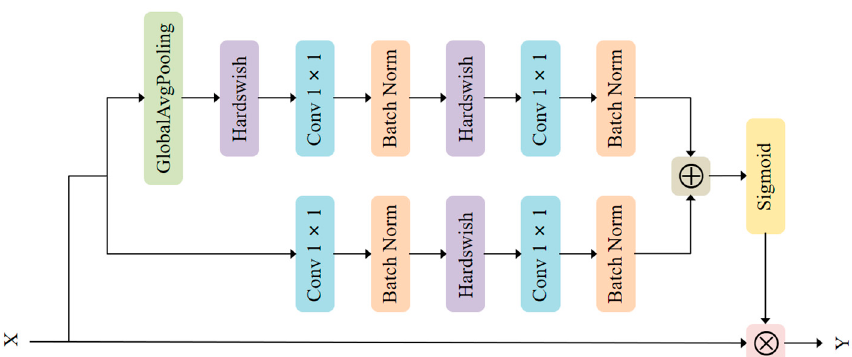
Figure 1. The MS-CAB structure. The global average pooling branch is the global channel attention, while the other is the local channel attention.